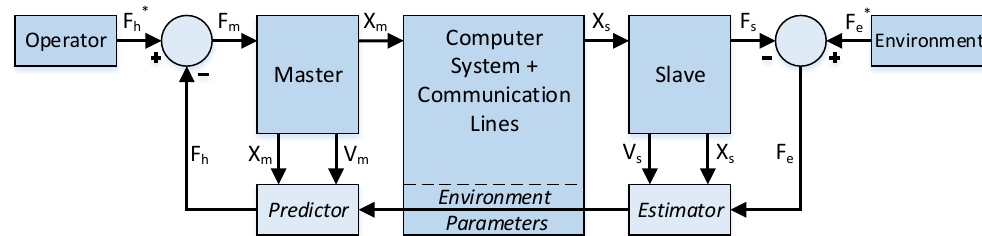
Figure 1. Environment estimation and force prediction controller